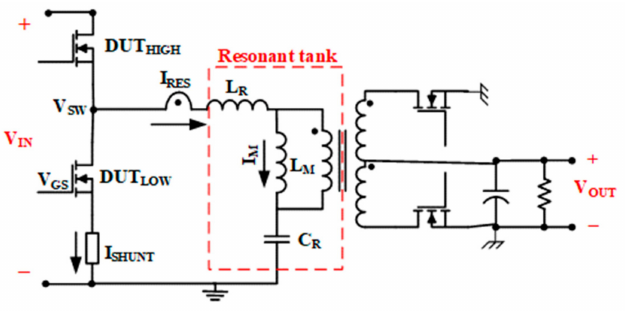
Figure 6. Simplified circuit scheme of the LLC resonant converter and sensing